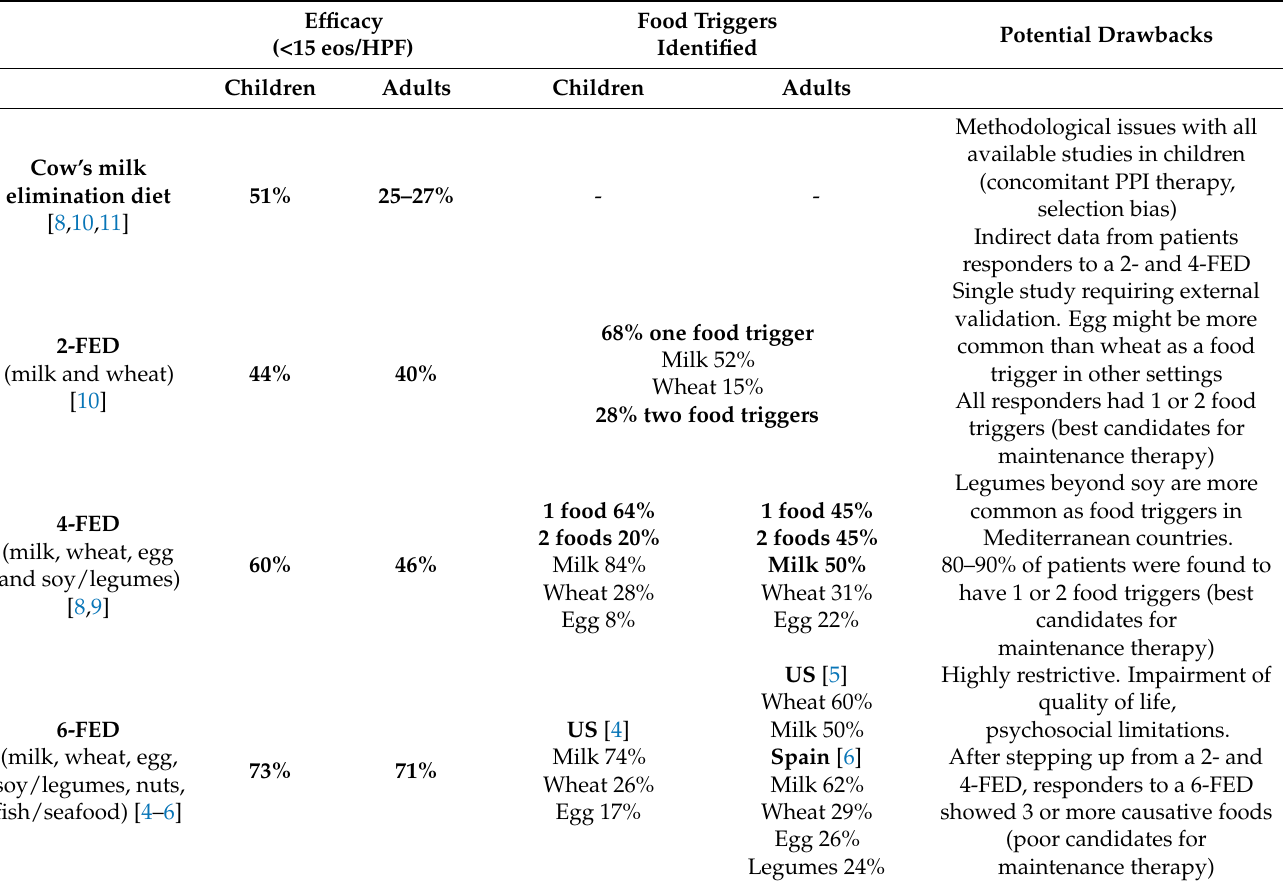
Table 1. Available empiric elimination diets in pediatric and adult EoE